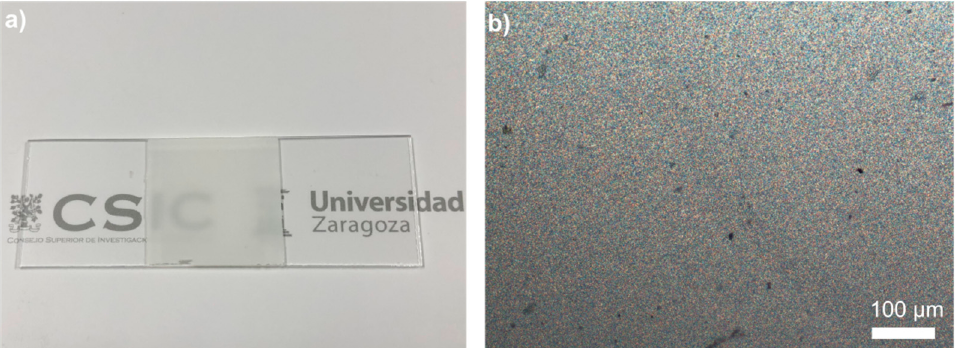
Figure 2. ( a ) Photograph of a 50 μ m-thick sample of LCP (26 mm × 26 mm) applied in the central part of a glass microscope slide (76 mm × 26 mm). The LCP film shows high turbidity at RT when compared to the bare glass (at the two sides of the LCP). ( b ) POM image of an LCP thin film sample